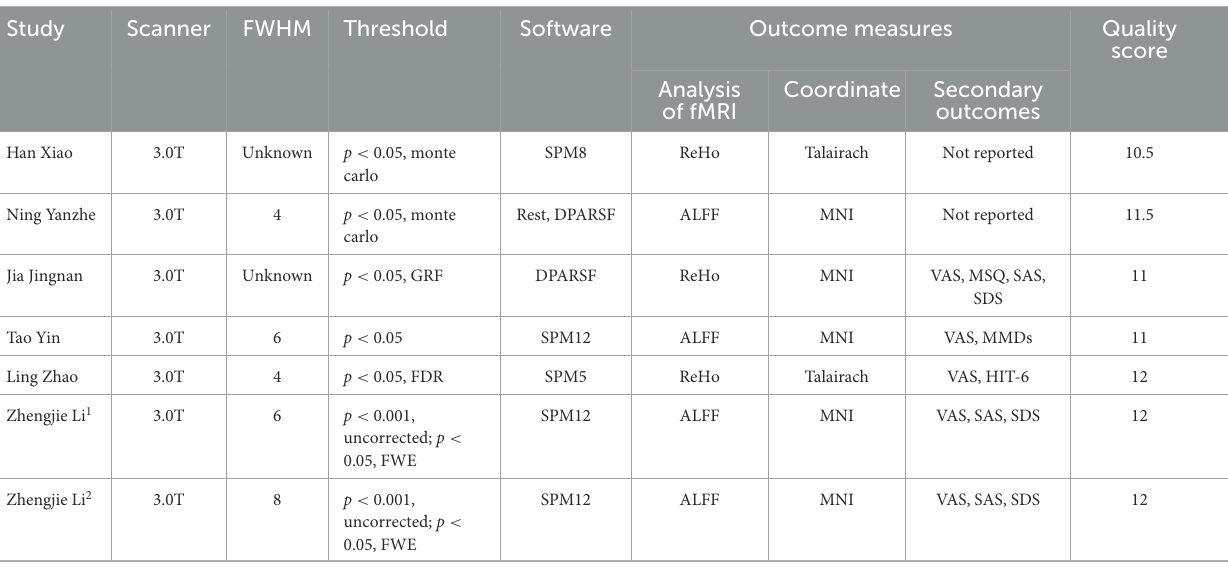
TABLE 2 Scanning methods in the included